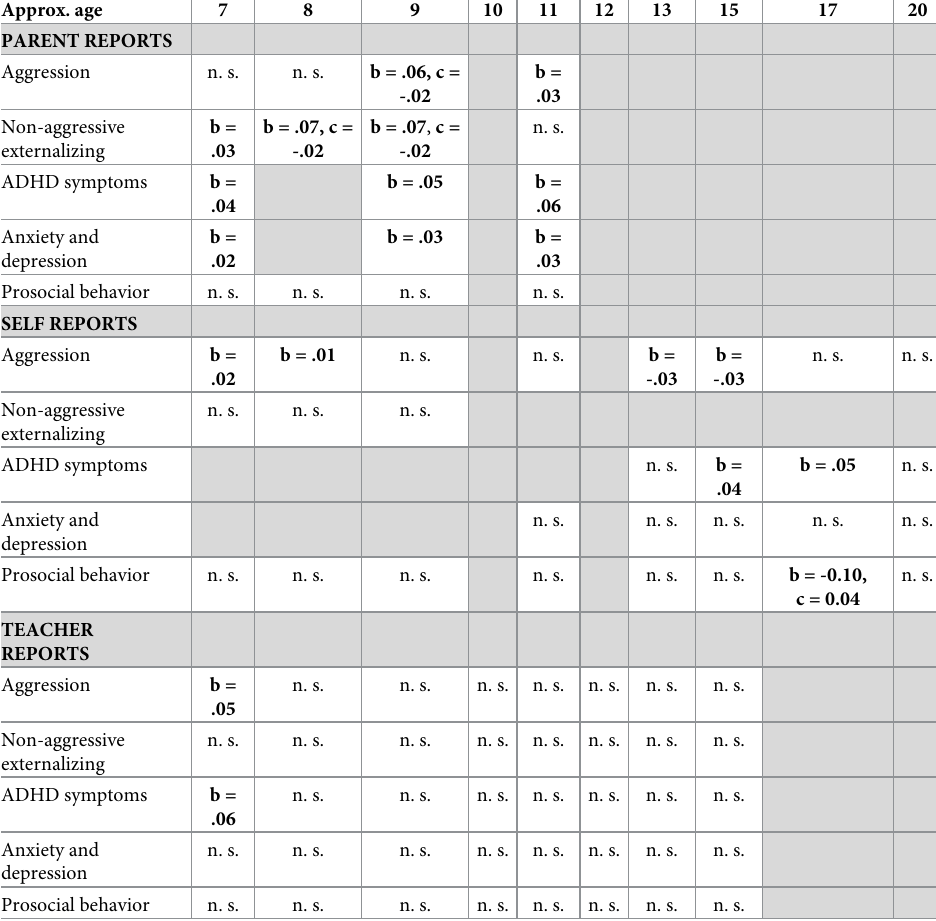
Table 3. Amount of time spent in a daycare center and social behavior by age. Unstandardized coefficients from growth curve